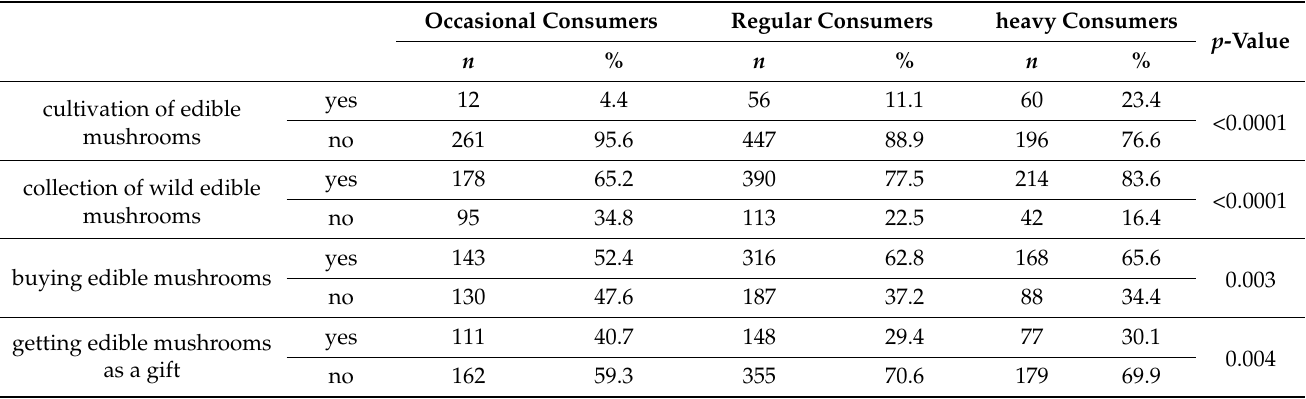
Table 9. Options for obtaining mushrooms for consumption in individual segments of edible mush- rooms